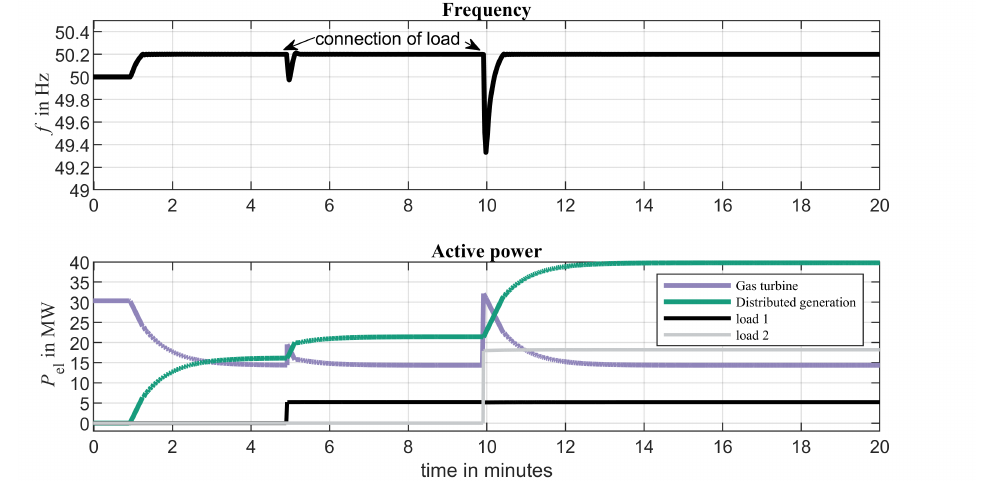
Figure 10. Base case simulation of load connection with 5MW and 17.5MW,